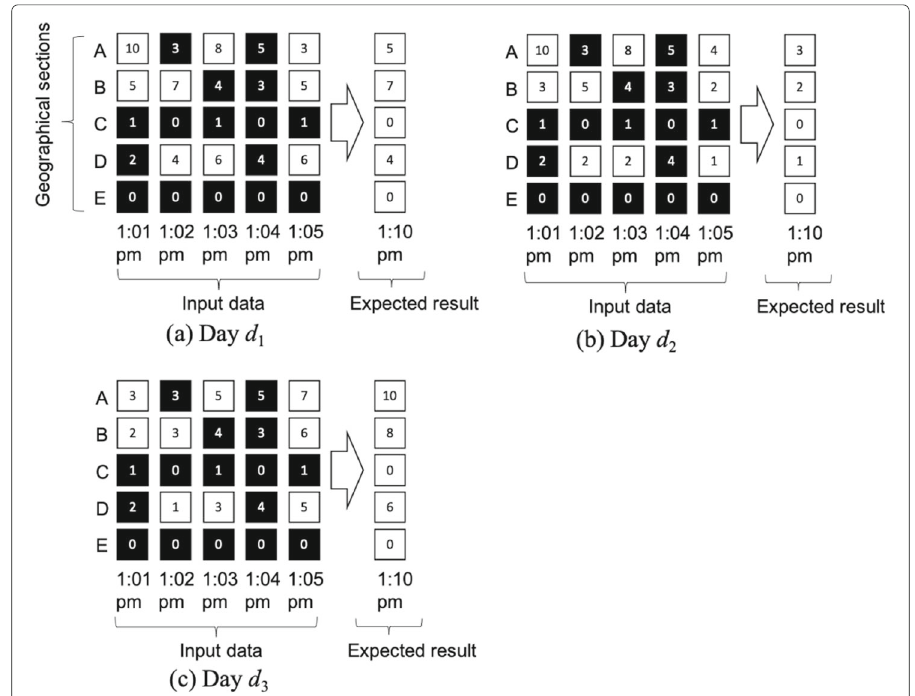
Fig. 4 Example patterns of spatial information recorded on different